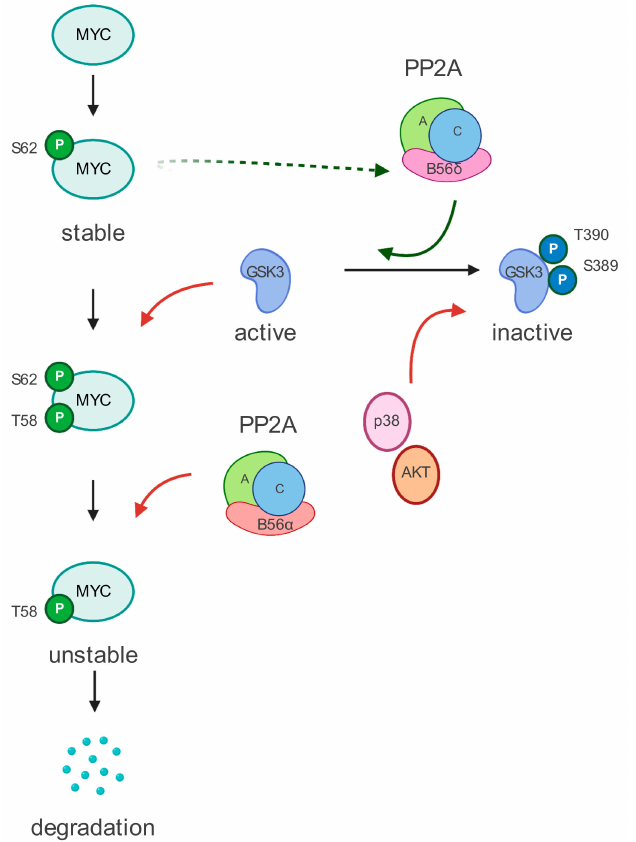
Figure 1. MYC regulation by PP2A. MYC undergoes two critical phospho-modifications on S62 and T58 residues. The phosphorylation on T58 is regulated by GSK3 β . To be active, GSK3 β has to be dephosphorylated. The PP2A complex, which includes the B56 α subunit, dephosphorylates and activates GSK3 β . Interestingly, the B56 α subunit is transcriptionally activated by MYC. Moreover, the presence of a phosphorylated T58 residue also recruits the PP2A-B56 α complex, which dephosphorylated the S62 phospho-residue. Dephosphorylation of S62 residue eventually targets MYC for ubiquitin-mediated proteosomal degradation. See text for more